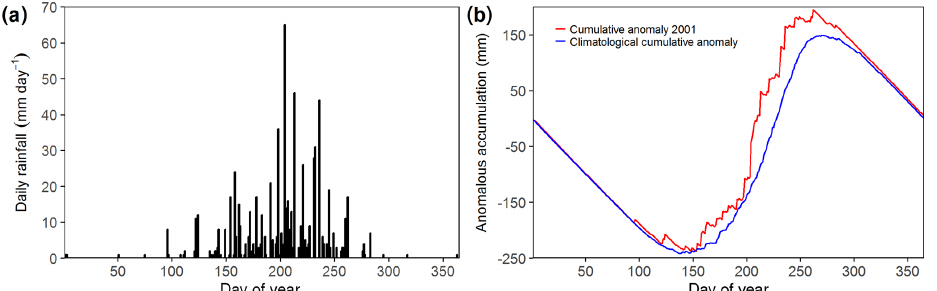
Figure 2. (a) Daily rainfall distribution and (b) anomalous accumulative curve for the grid point 13.5 ◦ N, 5.0 ◦ W (shown in Fig. 1) for the year 2001. The blue line (accumulated anomaly) is computed from a 15-year (2001–2015) average of daily rainfall.